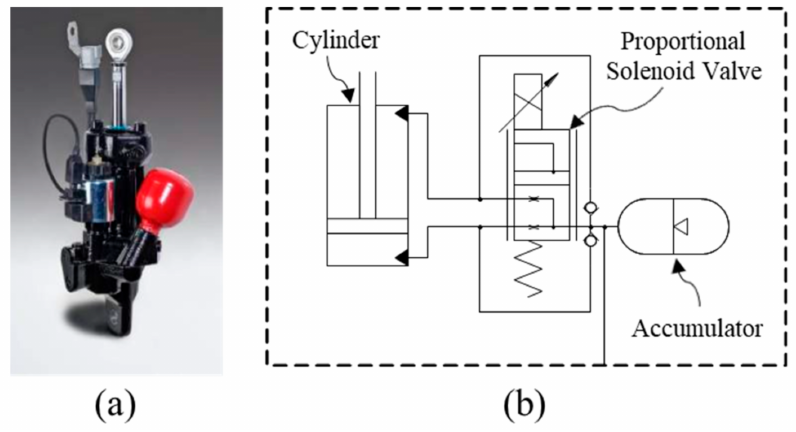
Figure 1. Hydro-pneumatic semi-active suspension: ( a ) Figuration and ( b ) hydraulic circuit diagram. Table 1. Specifications of hydro-pneumatic semi-active suspension.